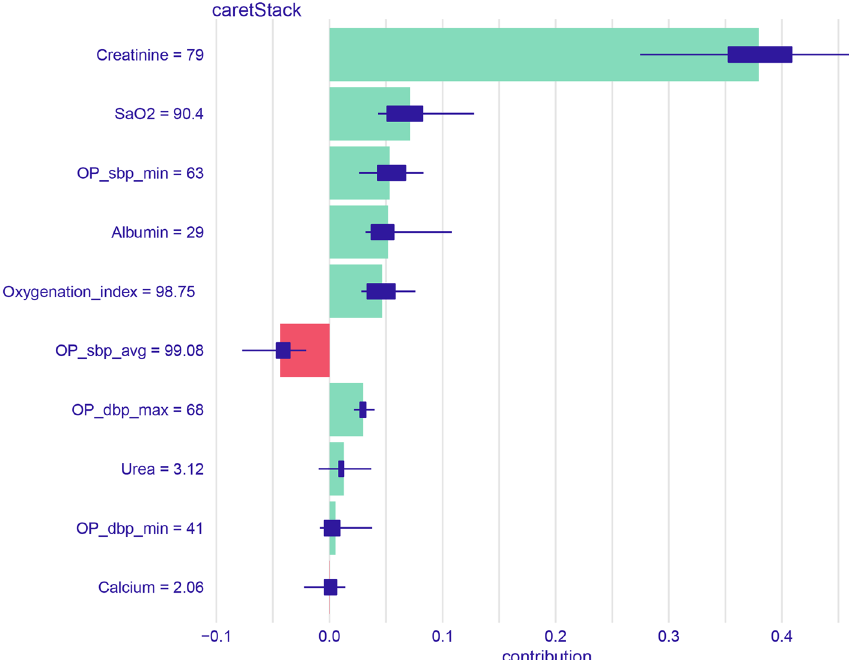
Figure 5. Model interpretation using the iBreakdown algorithm with uncertainty indicated by a box plot. The horizontal axis reflects the probability scale. SaO 2 , Oxyhemoglobin saturation; OP_sbp_avg, average systolic pressure; OP_dbp_min, Minimum diastolic pressure; OP_dbp_max, Maximum diastolic pressure; OP_sbp_ min, Minimum systolic